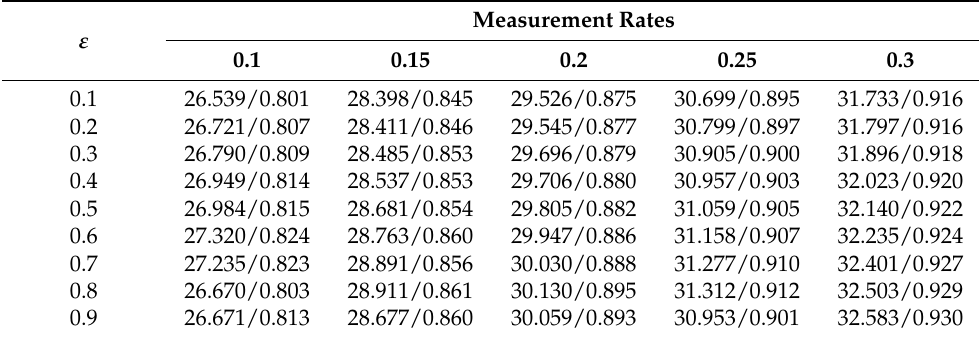
Table 1. Peak signal-to-noise ratio (PSNR) (dB)/structural similarity (SSIM) results for the different ε for Lena image.